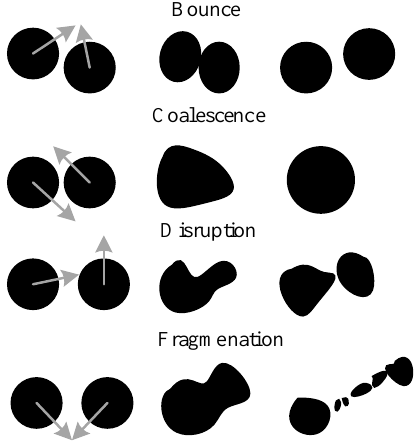
Figure 2. Typical droplet collision regimes described in [5]. Disruption